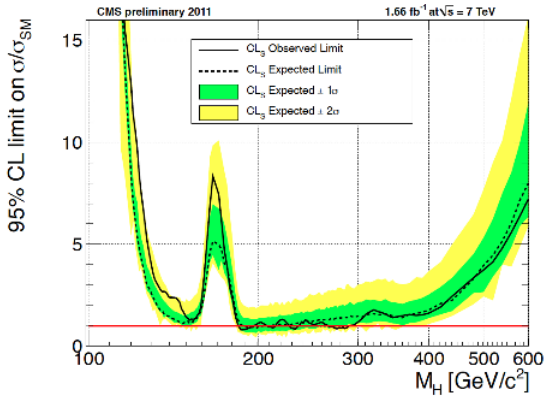
Fig. 5. The mean expected and the observed upper limits at 95% CL on σ ( pp → H + X ) × BR ( ZZ → 4 (cid:96) ) for a Higgs boson in the mass range 120 ÷ 600 GeV / c 2 , for an integrated luminosity of 1 . 66 fb − 1 using the CL s approach. The expected ratio for the SM is presented. The results are obtained using a shape analy- sis